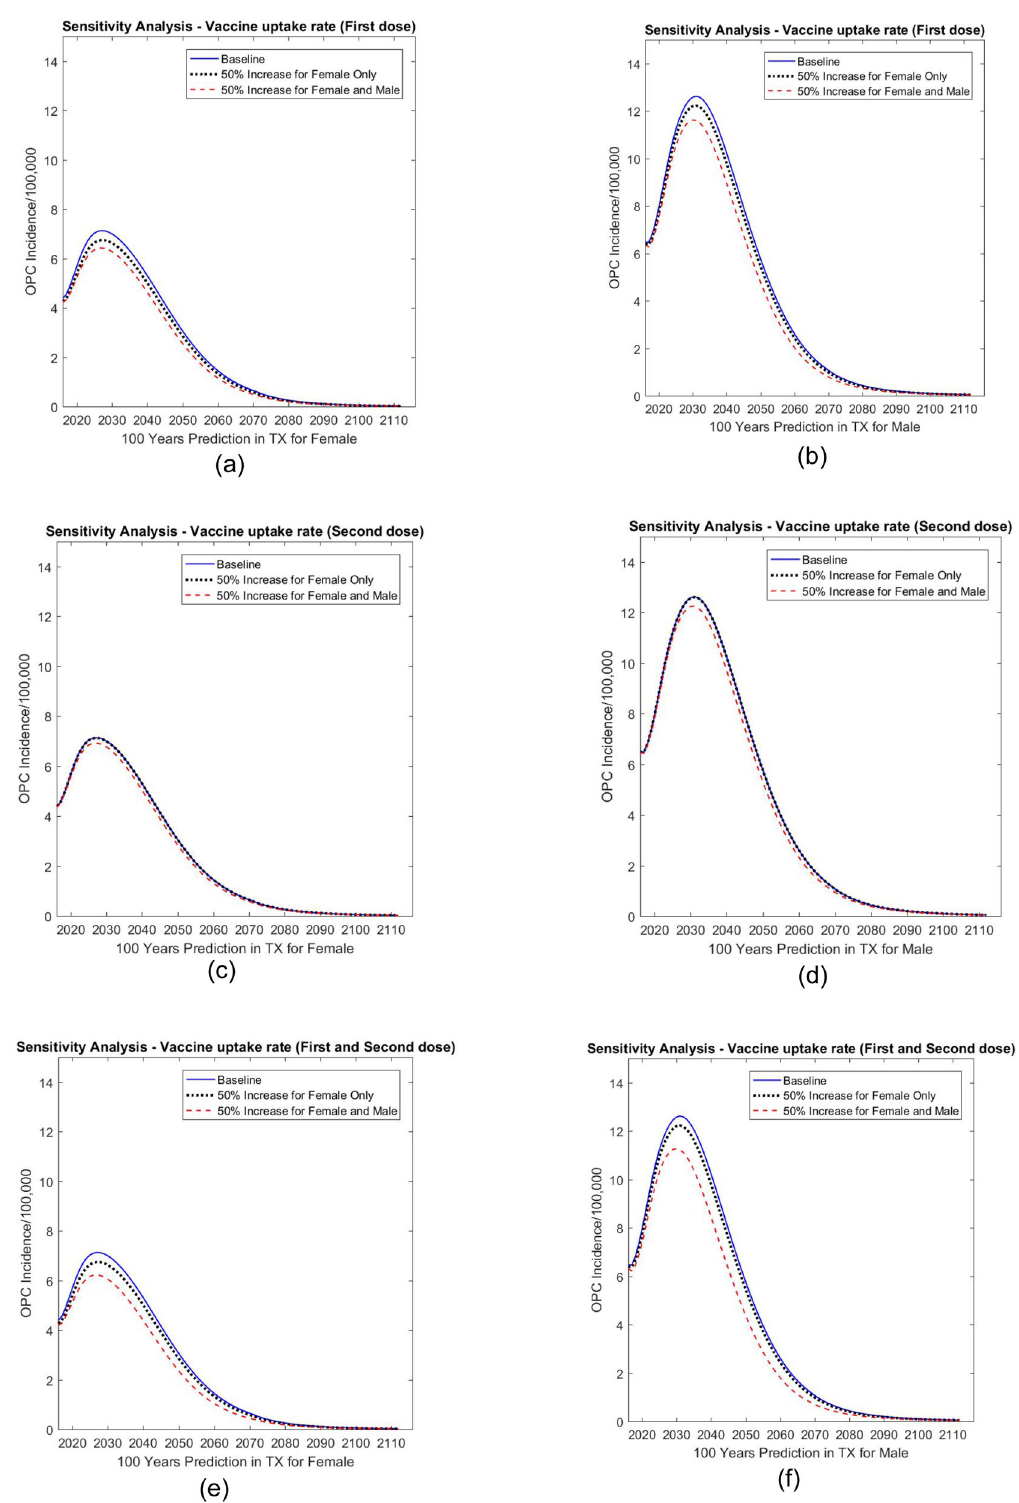
Figure 3. Sensitivity analysis: predicted effect of first dose ( a , b ), second dose ( c , d ), and first plus second dose ( e , f ) vaccine coverage rates on oropharyngeal cancer (OPC) incidence in Texas (TX). The graph on the left shows predictions for females; the graph on the right shows predictions for